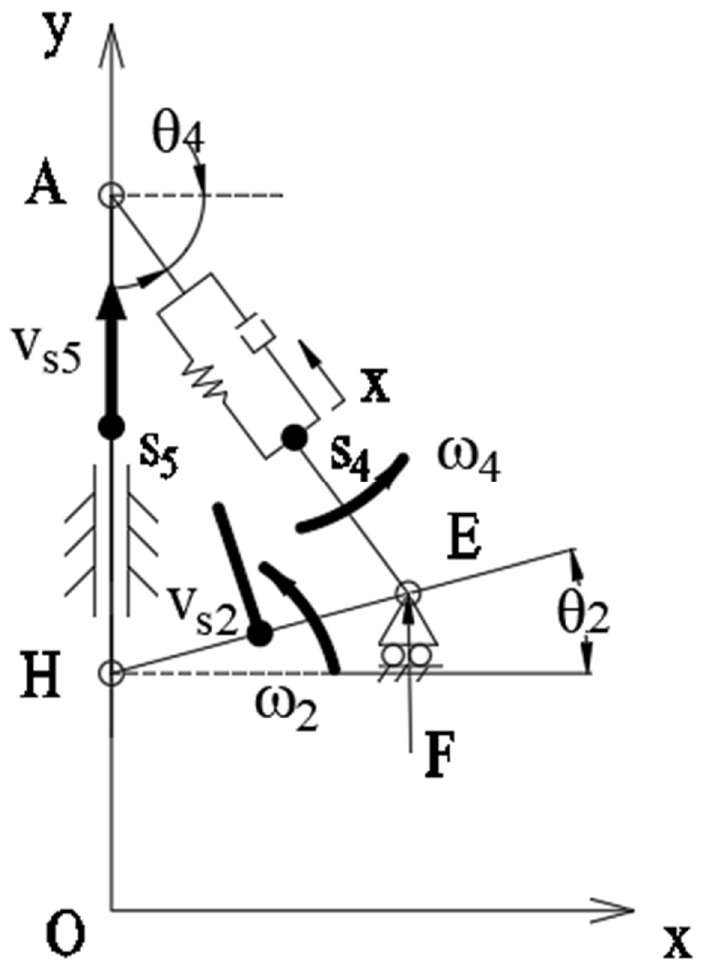
Figure 2. Motion analysis diagram of the quarter simplified model of suspension system. (A, E and H indicate the hinge connection points between the parts).